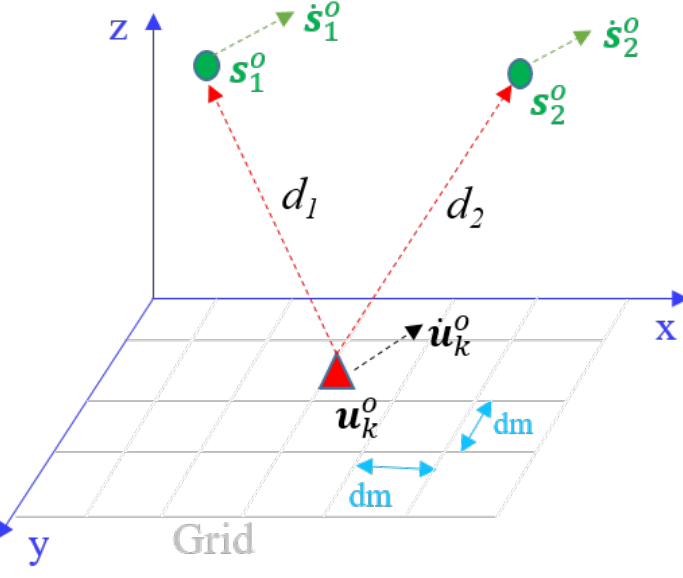
Figure 10. Example of geolocation